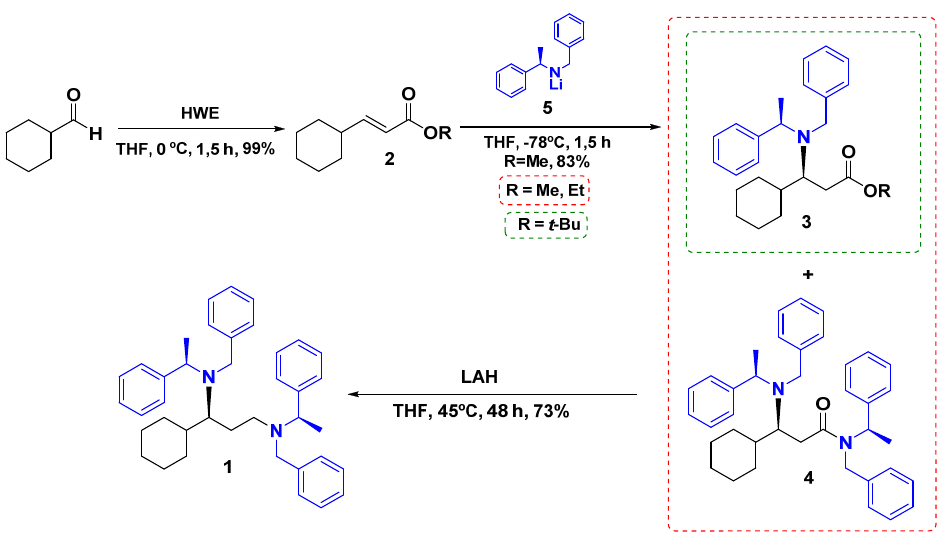
Figure 2. Synthetic pathway of 1 .